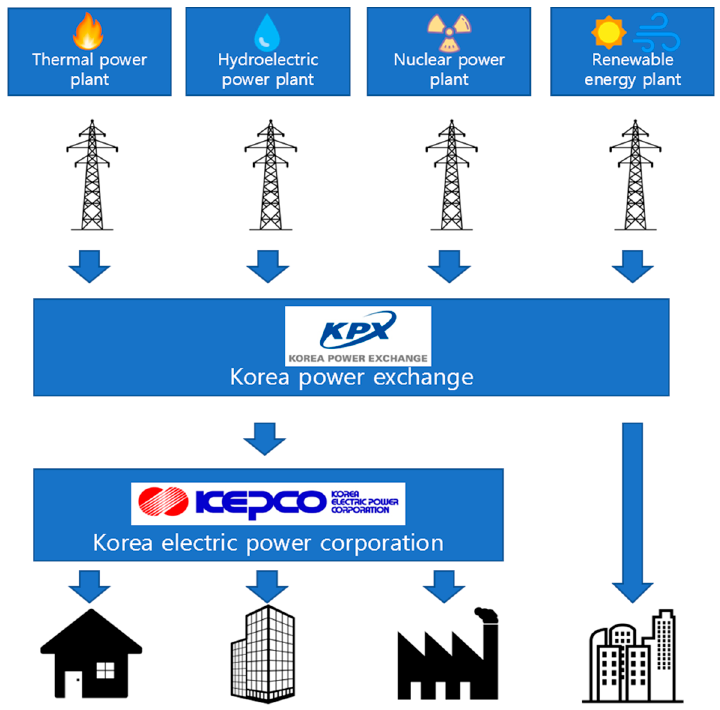
Figure 1. Korea energy system